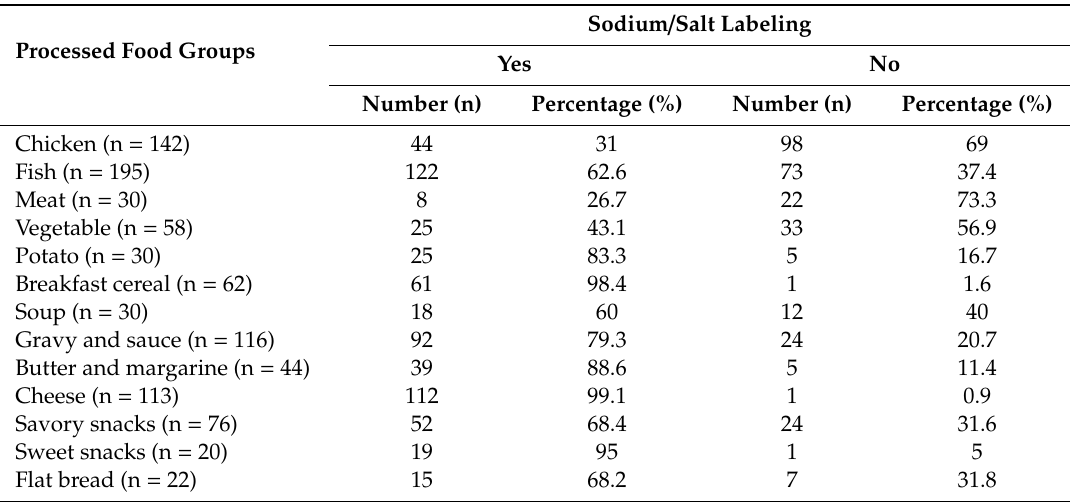
Table 1. Number and percentage of processed food with and without labeling of sodium and